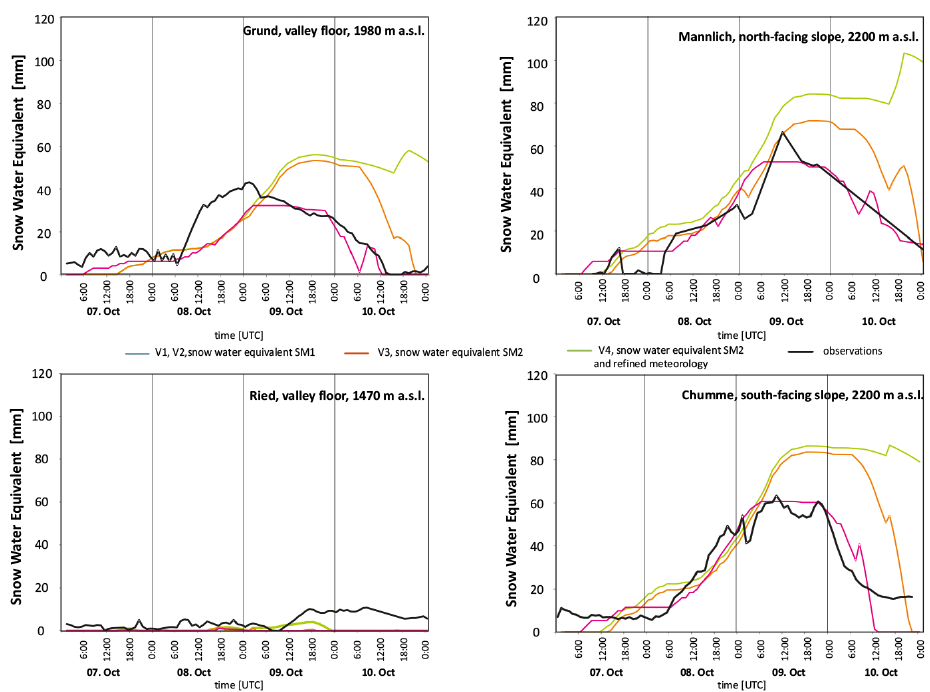
Figure 10. Snow model performance of standard (V1 and V2, green lines), and enhanced snow modules (V3, orange lines), as well as recalibrated SM2 under refined meteorology (V4, magenta lines) in terms of SWE at four different meteorological stations (Reid, Grund, Mannlich, Chumme, see Fig. 1) representing different altitudes and expositions. Observations (black line) are derived from snow height measurements assuming a snow density of 0.1gcm − 3